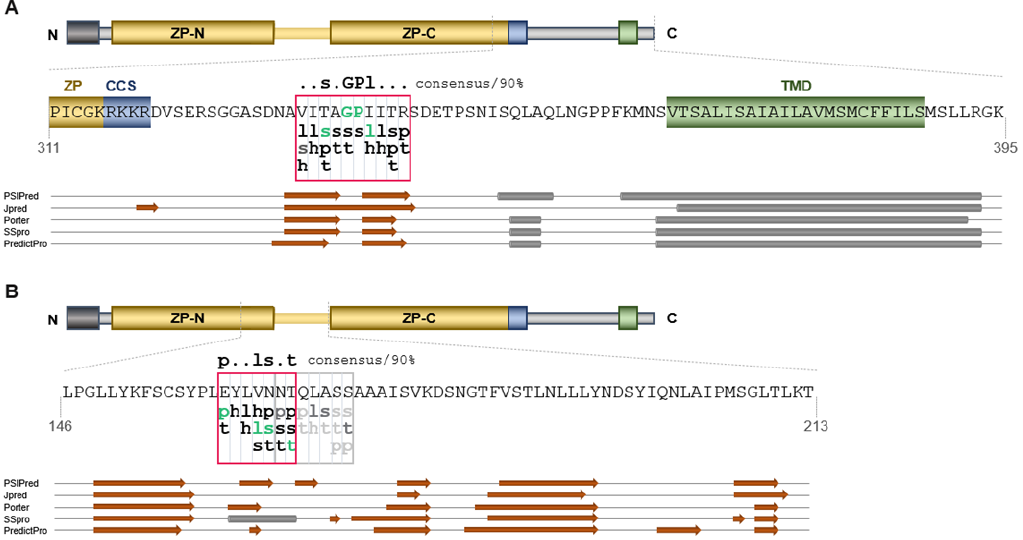
Figure 2. Identification of the putative IHP and EHP motifs within in ZPLD1 sequence. Scheme, detailed amino acid sequences, and annotated secondary structure predictions are shown for the EHP ( A ) and IHP ( B ). The signal peptide is shown as a dark grey box, the ZP module is shown in yellow and is likely divided in ZP-N and ZP-C domains. The consensus protease cleavage site (CCS) is shown in blue and the transmembrane domain (TMD) in green. The predicted hydrophobic patches are framed in red. Consensus with the amino acid grouping-set sequences for EHP (..s.GPl . . . /consensus 90%) and IHP (p..ls.t/consensus 90%) described by Schaeffer et al. is indicated as green lowercase letters [23]. The lowercase letters indicate the following grouping-sets: l, aliphatic (I, L, V); s, small (A, C, D, G, N, P, S, T, V); h, hydrophobic (F, H, I, L, M, V, W, Y); p, polar (C, D, E, H, K, N, Q, R, S, T); and t, turn-like (A, C, D, E, G, H, K, N, Q, R, S, T). Secondary structure predictions were performed with five different programs (for details see Section 4). β -strands are depicted as orange arrows, α -helices as gray